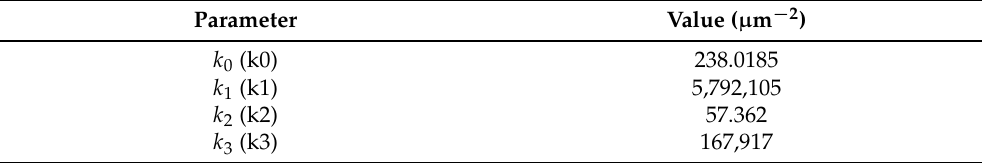
Table 3. Constants for variation of refractive index, see Equation